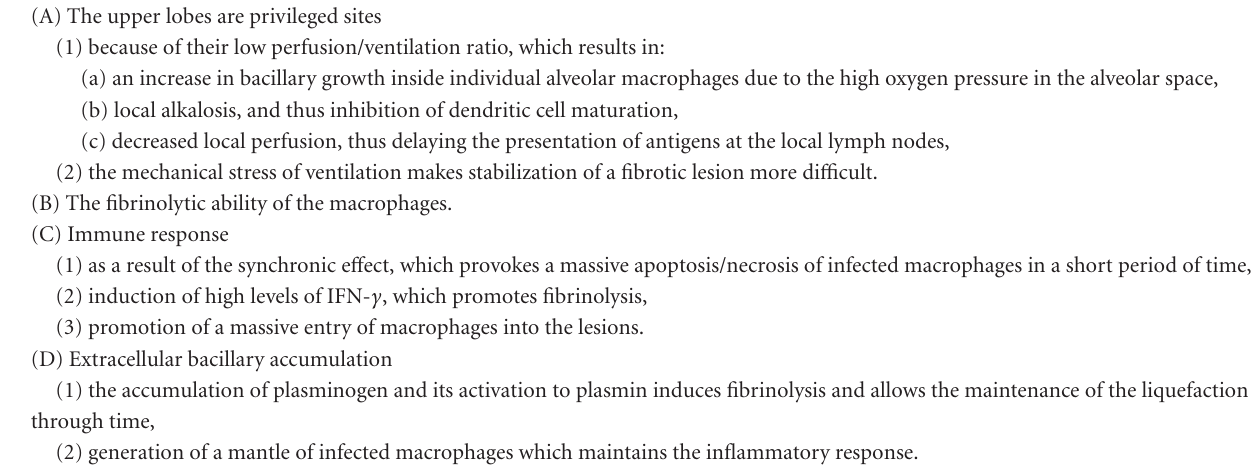
Table 1: The factors involved in